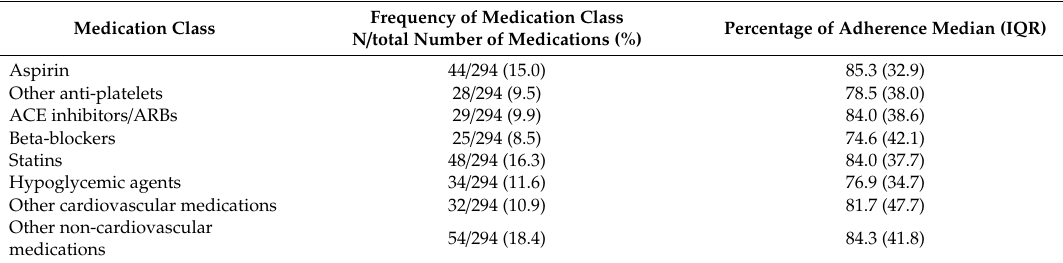
Table 6. Types of medications entered in the app and percentages of